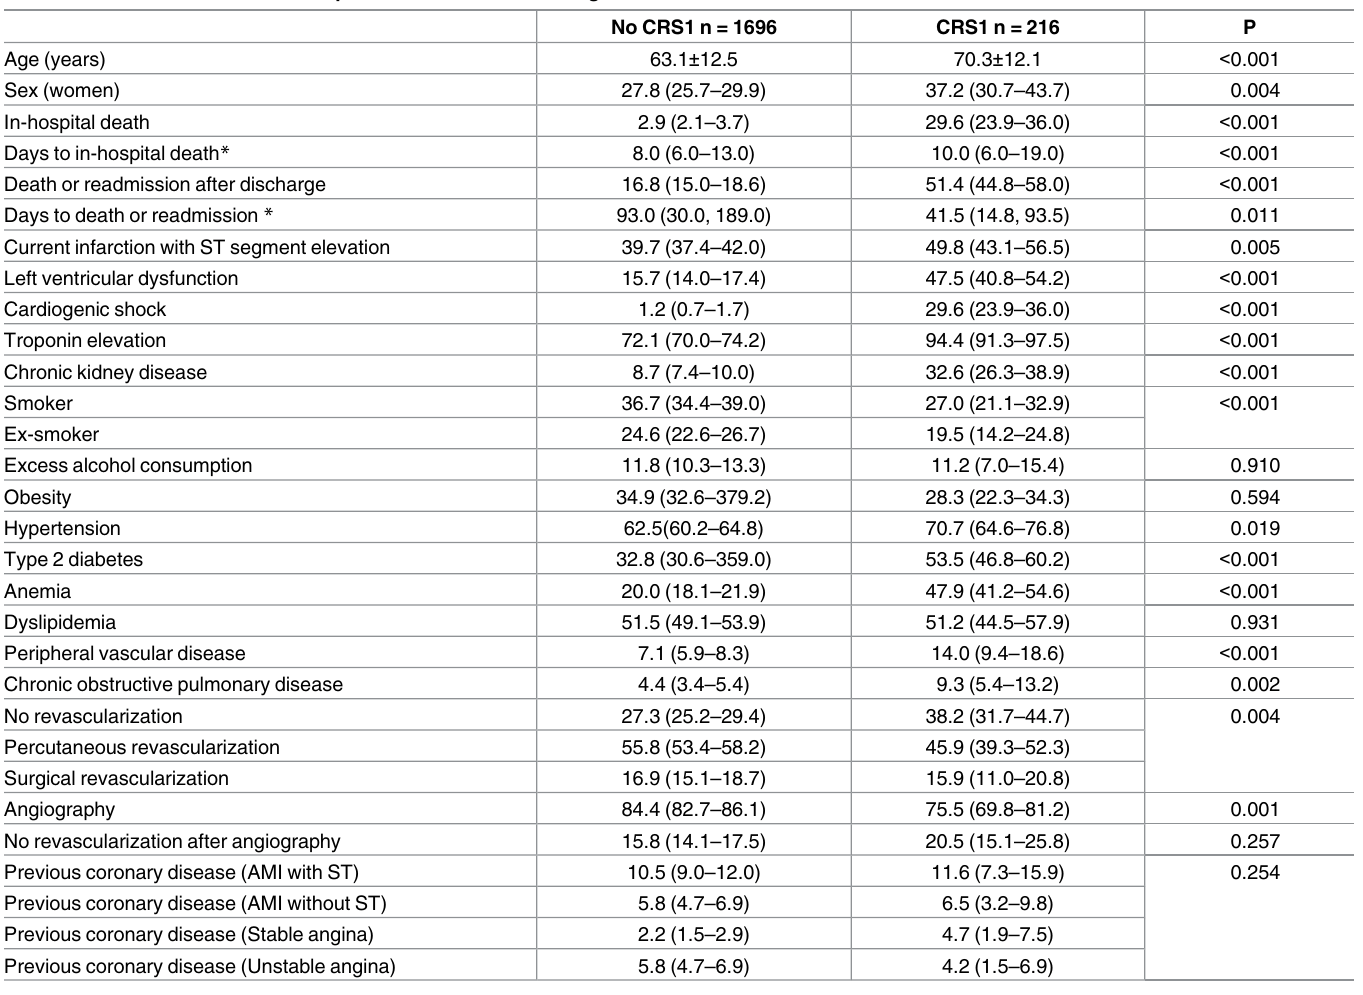
Table 1. Distribution of variables in patients with ACS according to sex and CRS1 status.